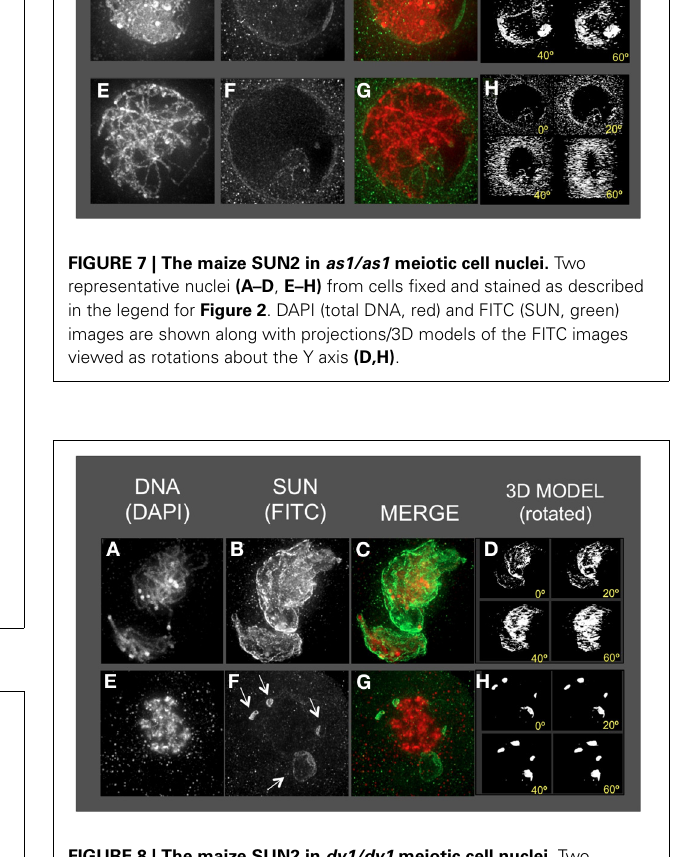
FIGURE 8 | The maize SUN2 in dv1/dv1 meiotic cell nuclei. Two representative nuclei (A–D , E–H) from cells fixed and stained as described in the legend for Figure 2 . DAPI (total DNA, red) and FITC (SUN, green) images are shown along with projections/3D models of the FITC images viewed as rotations about the Y axis (D,H) . Aberrant SUN localization structures (arrows in F ) are indicated.